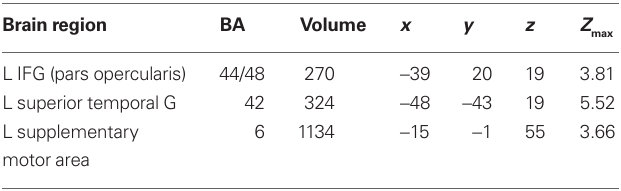
Table 3 | Psychophysiological interaction analysis.